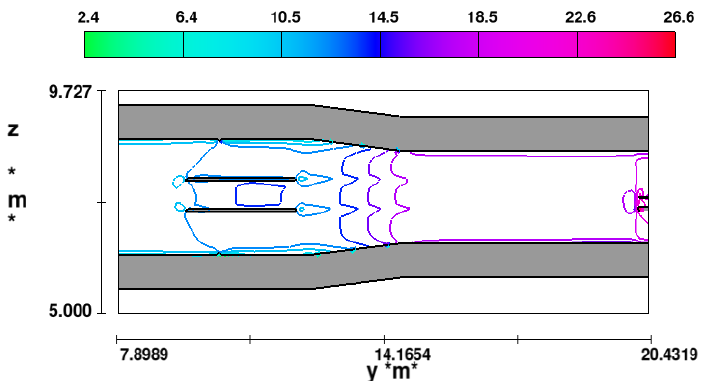
Figure 10. The Sectional view of velocity magnitude contours for the longitudinal distance between two valves = 4D.